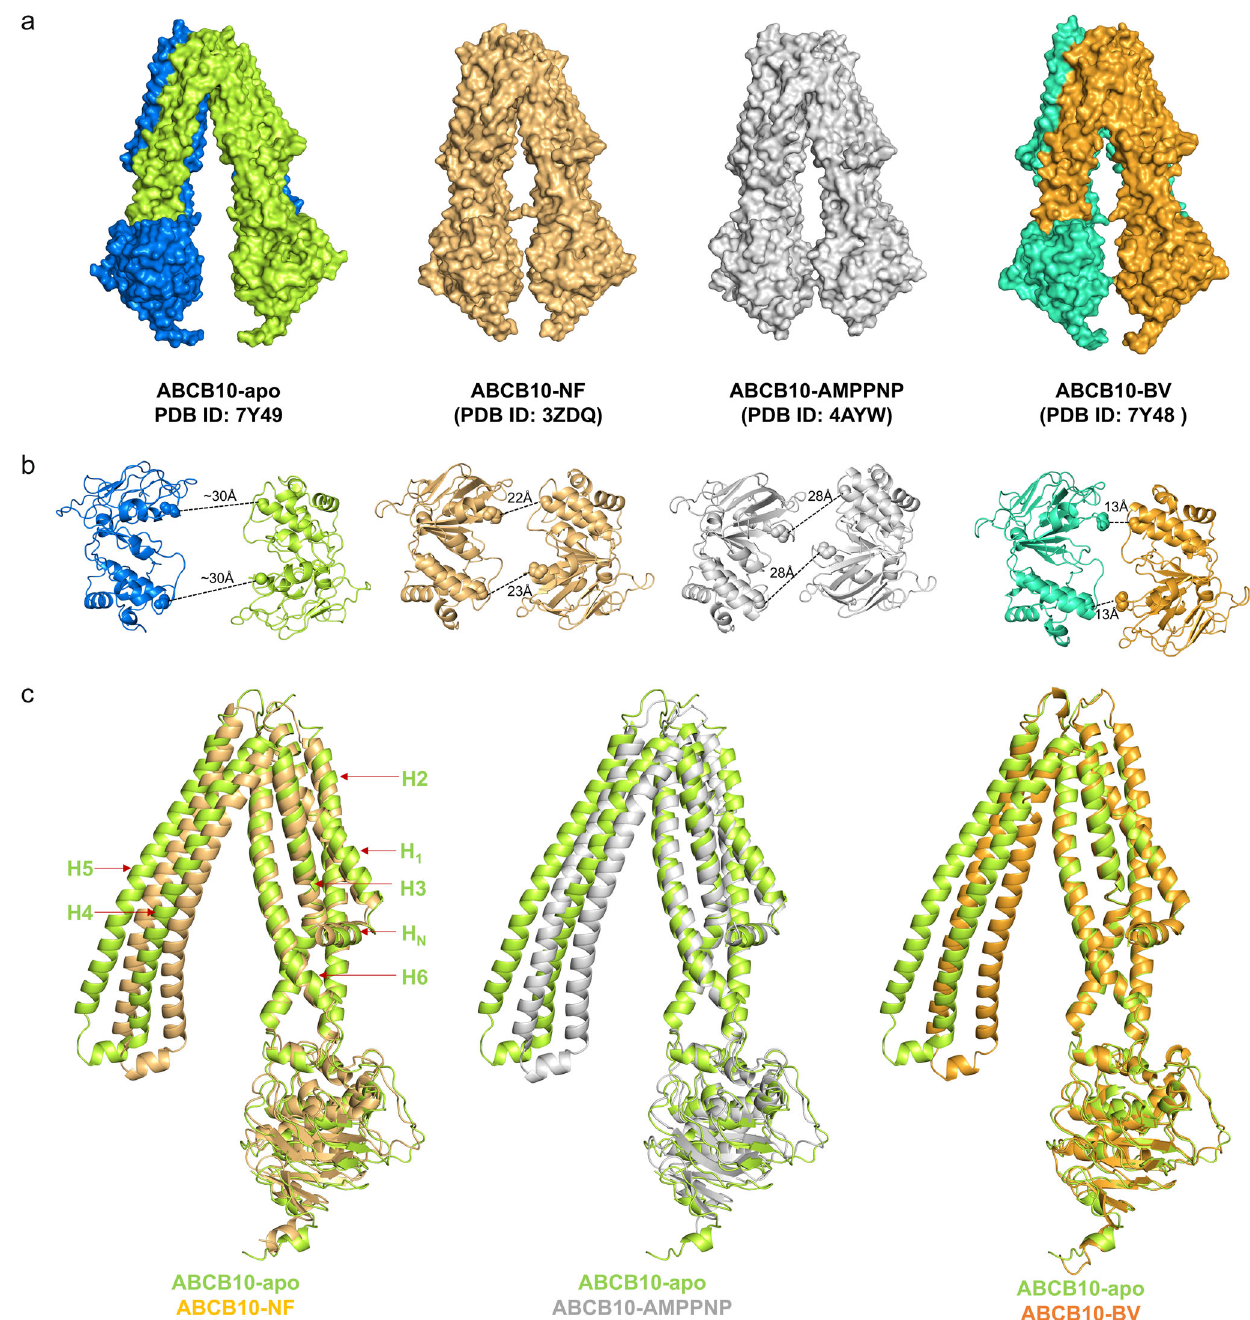
Fig. 3 | Structure comparison of ABCB10. a Surface drawing of ABCB10-apo, nucleotide-free form (ABCB10-NF), ATP analogs bound form (ABCB10-AMPPNP) and biliverdin-bound form (ABCB10-BV). b Alignment of NBDs of the structures shownin(A)viewedlookingtowardthemembrane.ThetwoNBDs,viewedfromthe